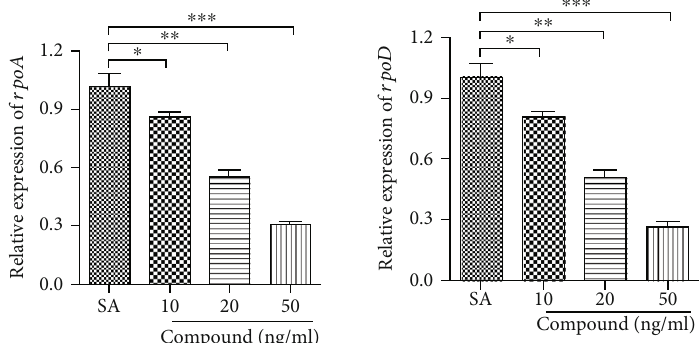
Figure 5: Compound obviously inhibited the relative expression of the Staphylococcus aureus bacterial survival gene. Staphylococcus aureus bacterial cells were incubated with serial di ff erent concentration of the compound. Then, the real-time RT-PCR was conducted, and the real- time RT-PCR was performed to determine the relative expression of the Staphylococcus aureus bacterial survival